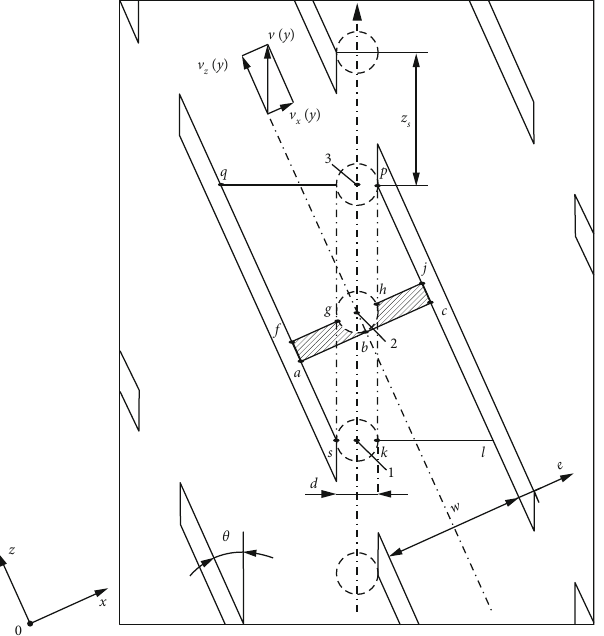
Figure 4: Partially developed view of the cylindrical outer surface of screw for the analysis of elongational deformation induced by pin ( θ : helical angle, d : pin diameter, W : normal screw channel width, e : normal screw fl ight width, z : screw fl ight slot length, s and v ( y ): fl uid con fl uence